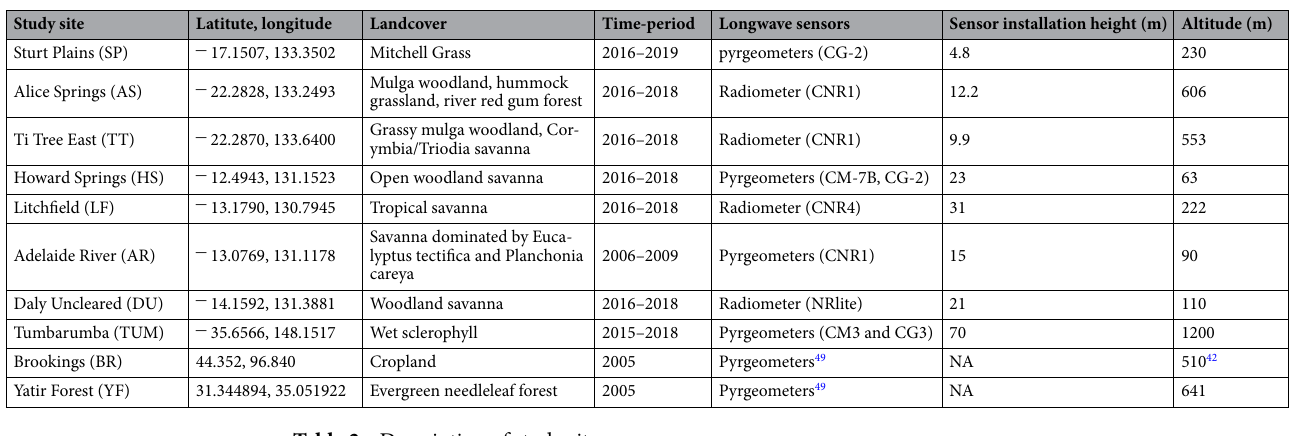
Table 2. Description of study